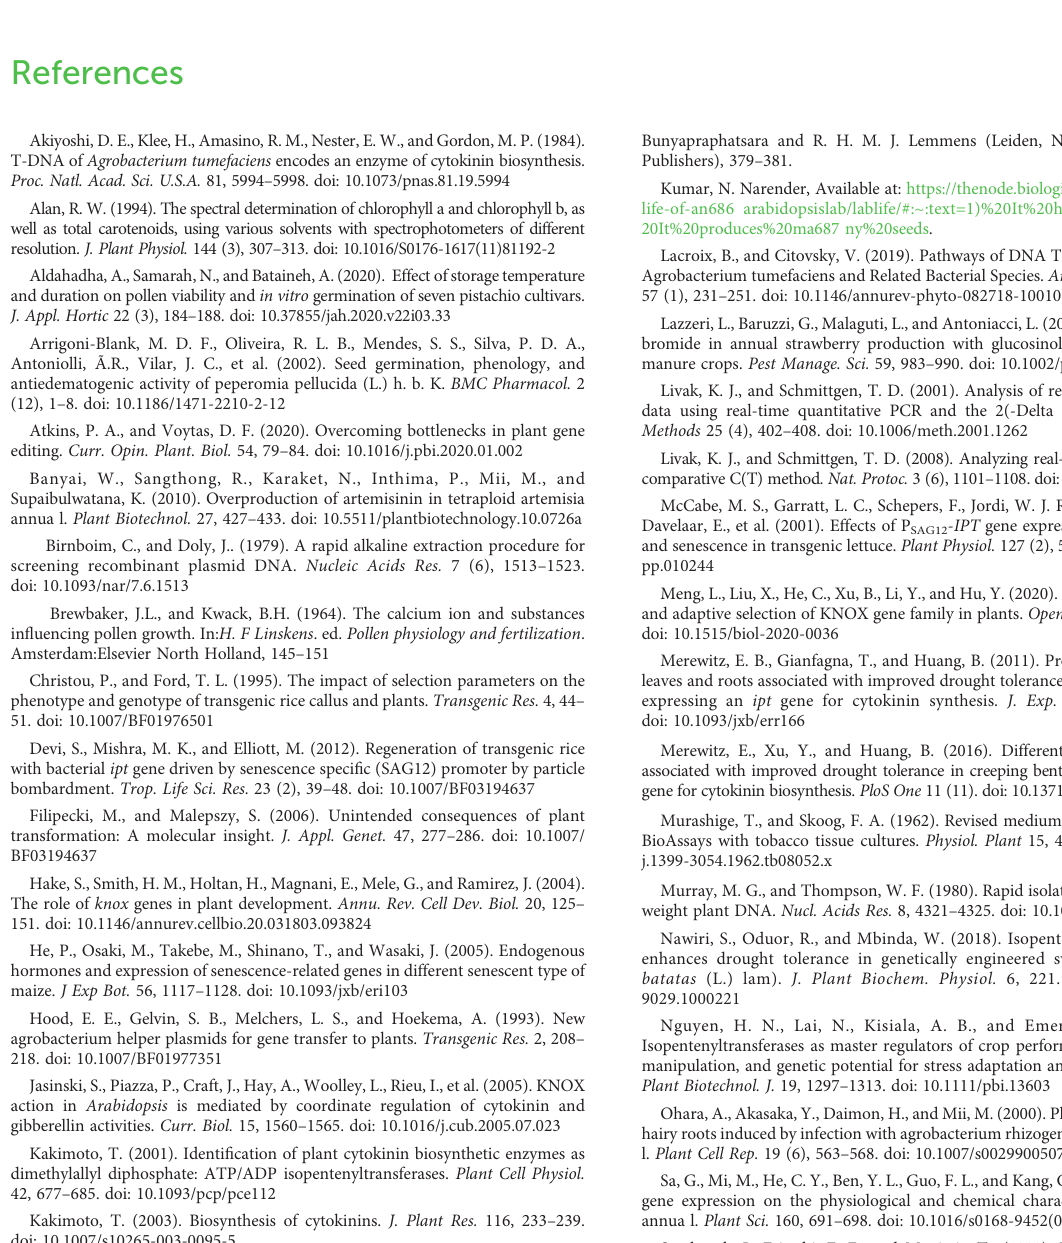
plant without ipt gene (P3300); Lanes 2 – 3, transgenic ipt plants with KNOX1 promoter (k-14, k-20); Lanes 4 – 6, transgenic ipt plants with 35S promoter (c-11, c-12, c-15); Lane 7, wildtype plant. SUPPLEMENTARY FIGURE 3 Nucleotide sequence and conserved region of IPT and IPT3 gene. SUPPLEMENTARY TABLE 1 List of primer sequences used for PCR and qPCR